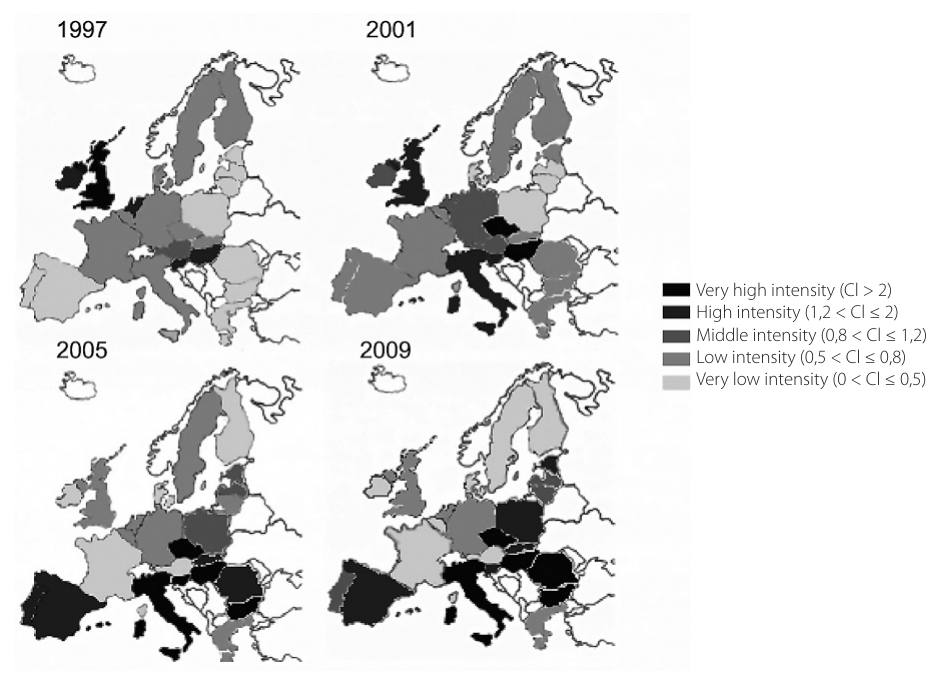
Fig. 2. Evolution of the Certification Intensity of ISO 9000 in the EU Source: Own preparation on the basis of data obtained from ISO reports and from Eurostat. Note: Calculations made on the basis of GDP for 2004 measured in terms of PPP (purchasing power